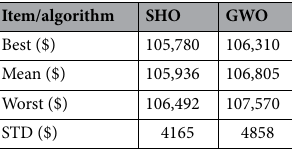
Table 4. Statistic analysis of different algorithms performance with cosφ = 1.